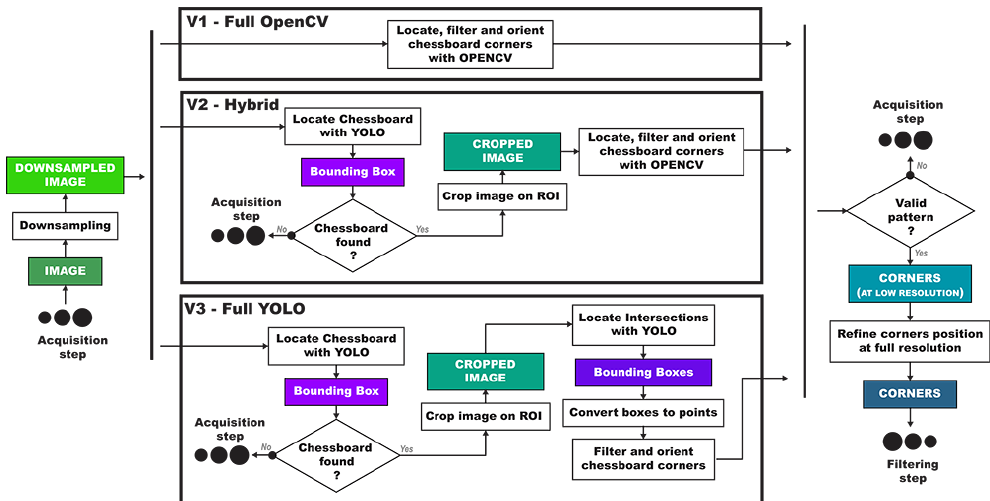
Figure 3. Detailed flowchart of the optimized chessboard detection step in its three variations: full OpenCV (V1), hybrid (V2), and full YOLO